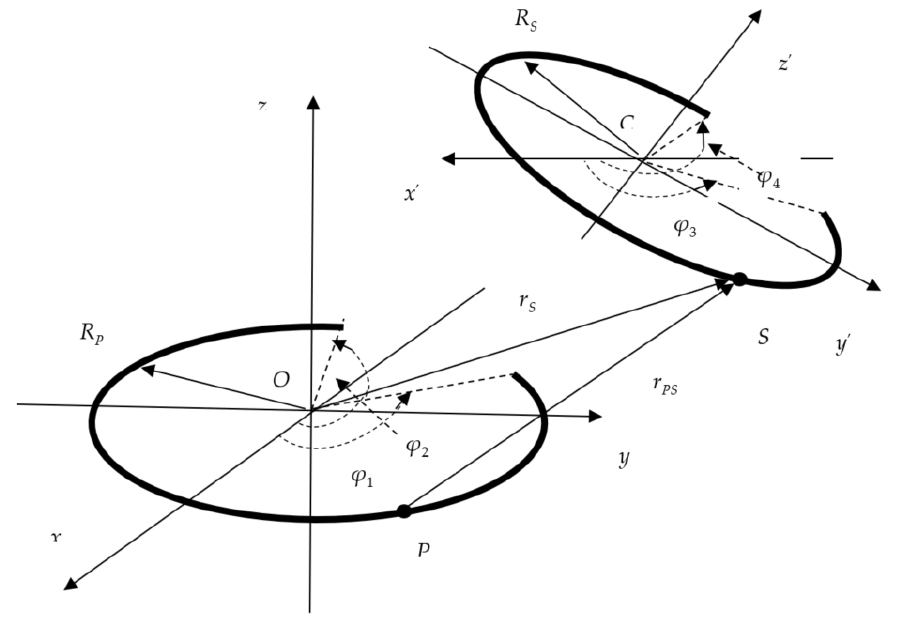
Figure 1. Two inclined current-carrying arc segments.